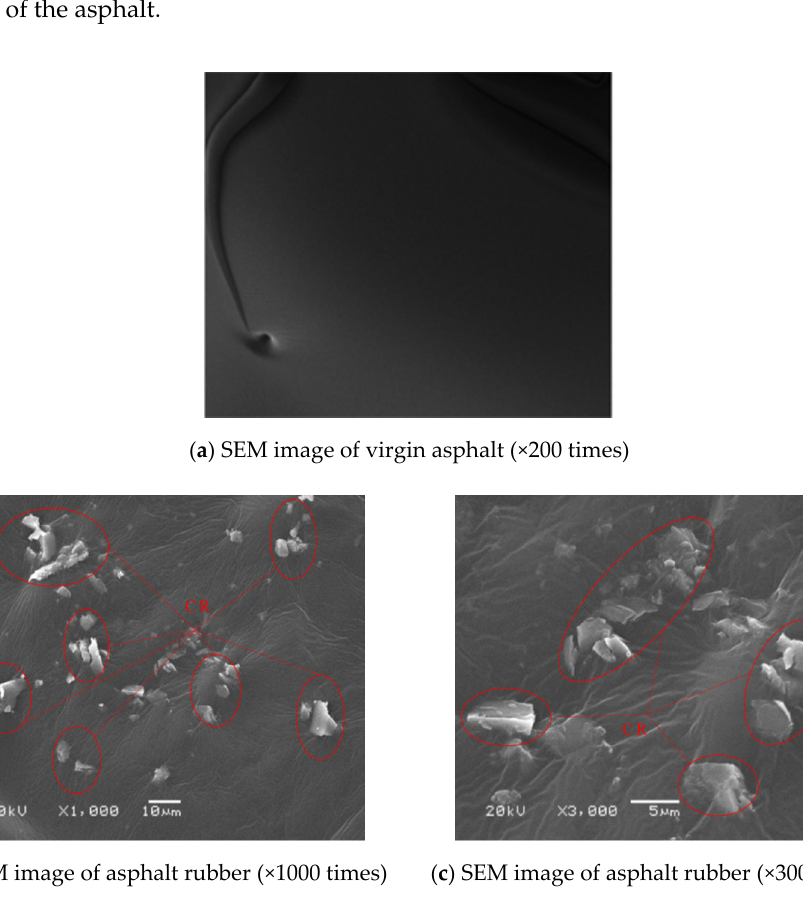
Figure 7. SEM images of asphalt and asphalt rubber.